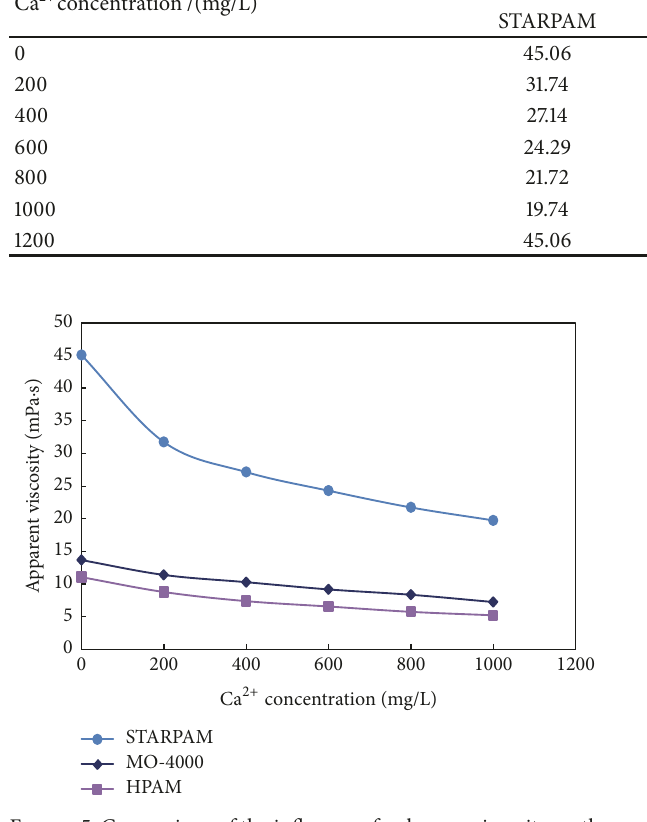
Figure 5: Comparison of the influence of polymers viscosity on the Ca 2+ .